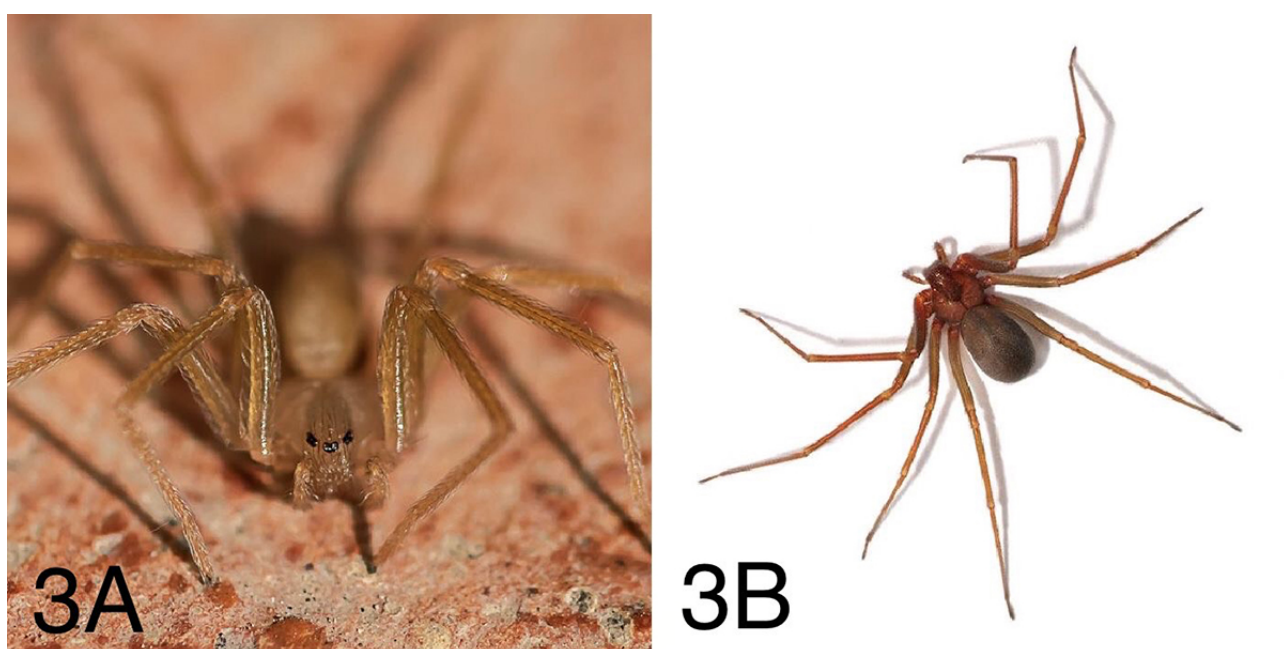
Figure 3. (A) Loxosceles rufescens (photo courtesy of Gianluigi Foggia). (B) Loxosceles rufescens (photo courtesy of Pierluigi Rizzo). catalyze the hydrolysis of the membrane